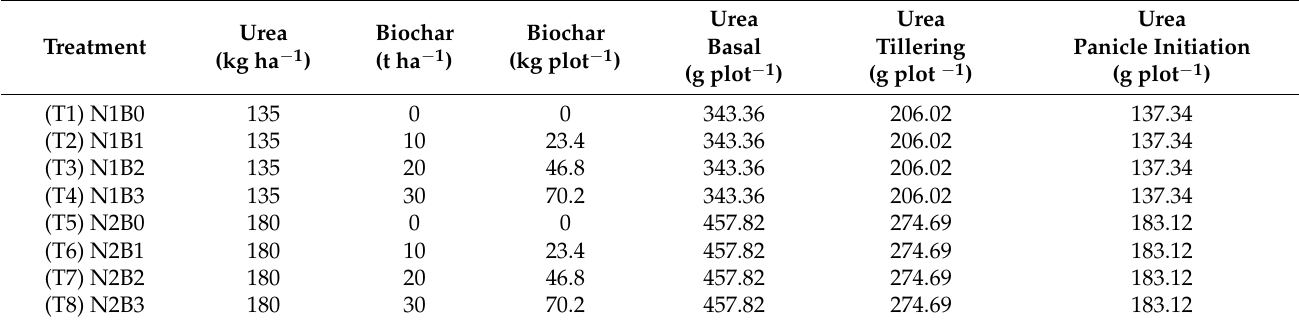
Table 1. Rate and timing of biochar and urea